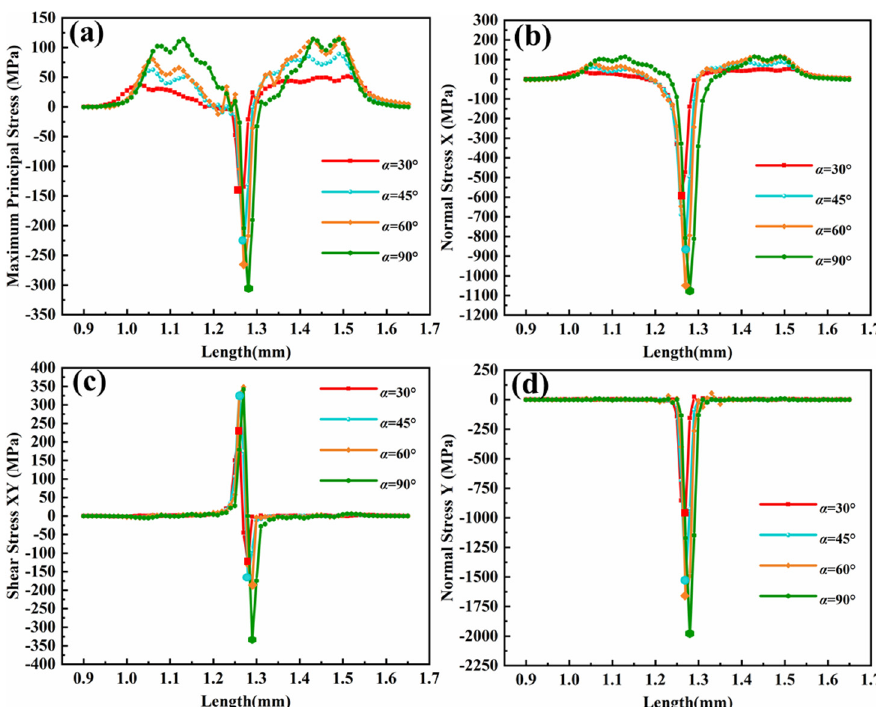
Figure 11. The plot of the ( a ) maximum principal stress, ( b ) normal stress X, ( c ) shear stress XY and ( d ) normal stress Y at the point of contact with the impact velocity 100 m/s under the different impact angle.